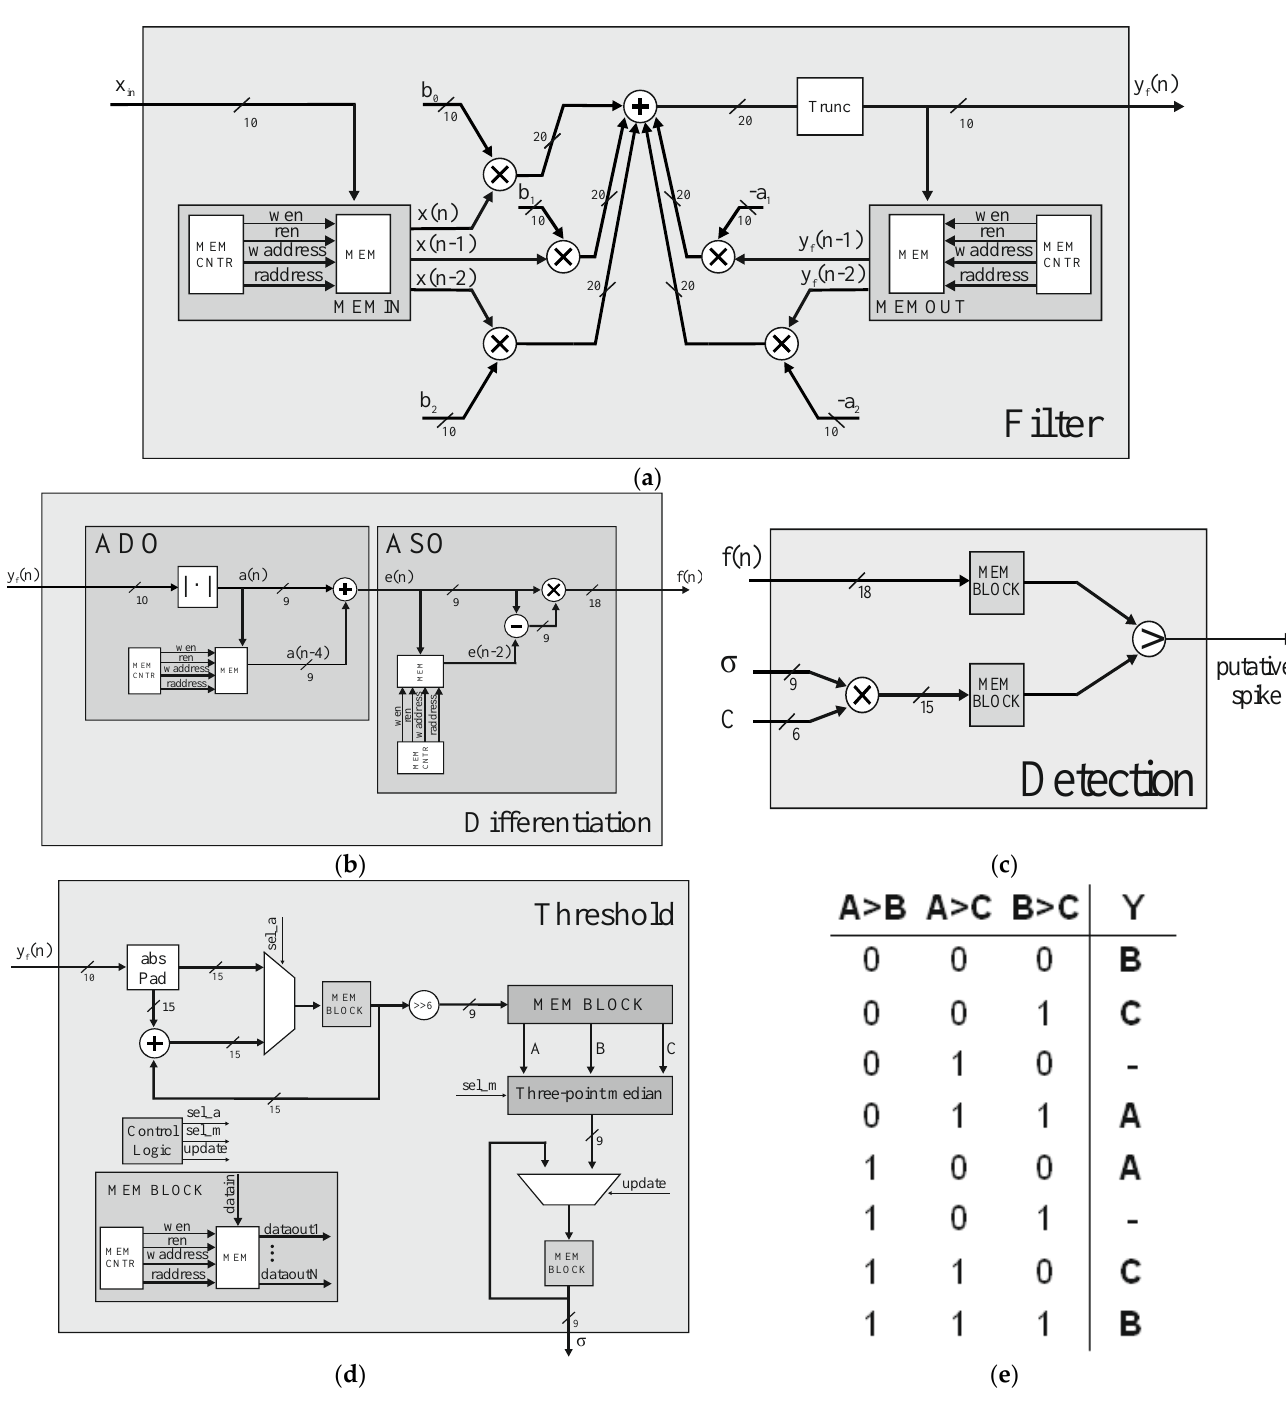
Figure 5. Hardware block scheme of the proposed spike detector. ( a ) IIR 2nd filter based on the direct form I with 10-bit width coefficients. The numerator coefficients were scaled to prevent overflow. The fixed-point filter maintains its stability. ( b ) Series of energy operator ADO and ASO while ( c ) the detection block, together with the multiplication of the noise estimate with the scale factor C. ( d ) Noise estimator based on absolute mean and three-point median operator whose outputs were chosen according to ( e ) the truth table.